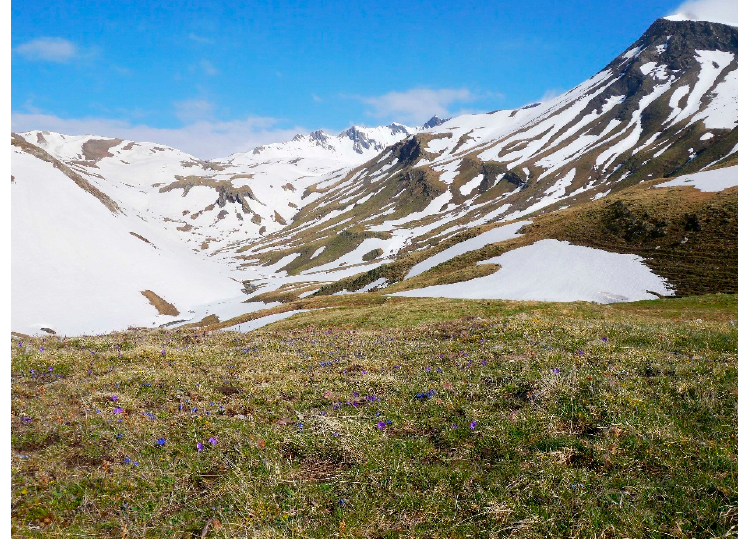
Figure 2. Photo of spring snowmelt near the Col du Lautaret (Figure 1), showing characteristic spatial heterogeneity in snow cover duration and the differential timing of plant green-up. ©Philippe Choler/Station Alpine Joseph-Fourier.